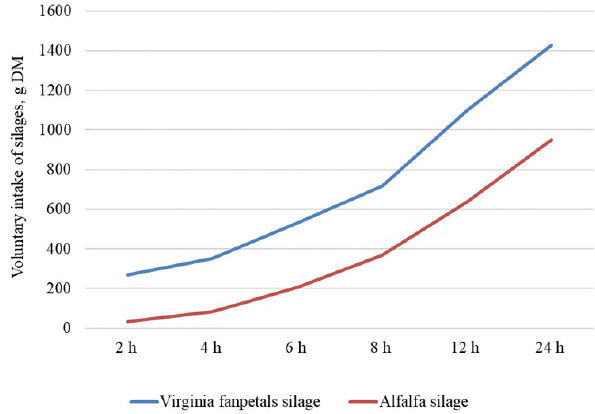
Figure 1. Rate of voluntary intake of silage in a preference test (g DM).